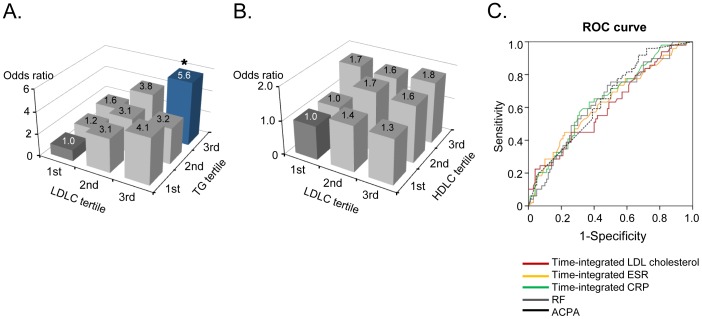
Comparison of the effects of LDL cholesterol levels, other lipid levels, and conventional prognostic factors on radiographic progression of rheumatoid arthritis.(A) Adjusted odds ratio of radiographic progression with combination of time-integrated LDL cholesterol and triglyceride levels. (B) Adjusted odds ratio of radiographic progression with combination of time-integrated LDL cholesterol and HDL cholesterol levels. The first tertile of lipid levels (dark gray column) was the reference group. All were adjusted for the following variables: age, body mass index, disease duration, presence of ACPA and RF, time-integrated ESR levels, time-integrated CRP levels, and methotrexate use. P-values are obtained from comparison with the reference group. *P<0.05 for the blue column. (C) Receiver operating characteristic curves of time-integrated LDL cholesterol, time-integrated ESR levels, time-integrated CRP levels, RF, and ACPA for prediction of radiographic progression. Area under the curve was 0.609 for time-integrated LDL cholesterol, 0.631 for ESR, 0.648 for CRP, 0.634 for RF, and 0.648 for ACPA. See the Table 1 for abbreviations.